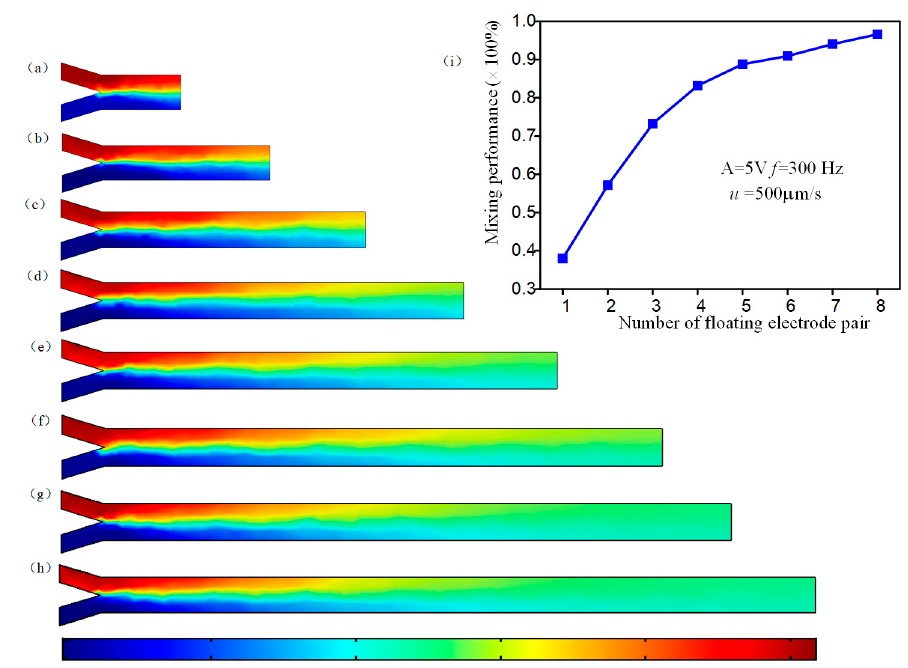
Figure 6. Mixing performance of the device with different number of herringbone floating electrode pairs. ( a – h ) The simulation results of the micromixer with different amount of Herringbone floating electrode pair; ( a ) a pair; ( b ) two pairs; ( c ) three pairs; ( d ) four pairs; ( e ) five pairs; ( f ) six pairs; ( g ) seven pairs; ( h ) eight pairs; ( i ) the curve illustrating the mixing performance and the number of herringbone floating electrode pair.